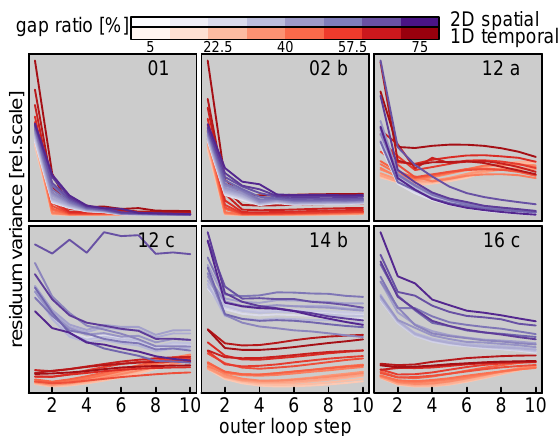
Fig. 9. Comparison of the residual variance of the spatial 2-D vs. the temporal 1-D SSA reconstructions for selected test datasets as a function of the outer loop step. Test datasets not visualised here show similar patterns as the example datasets